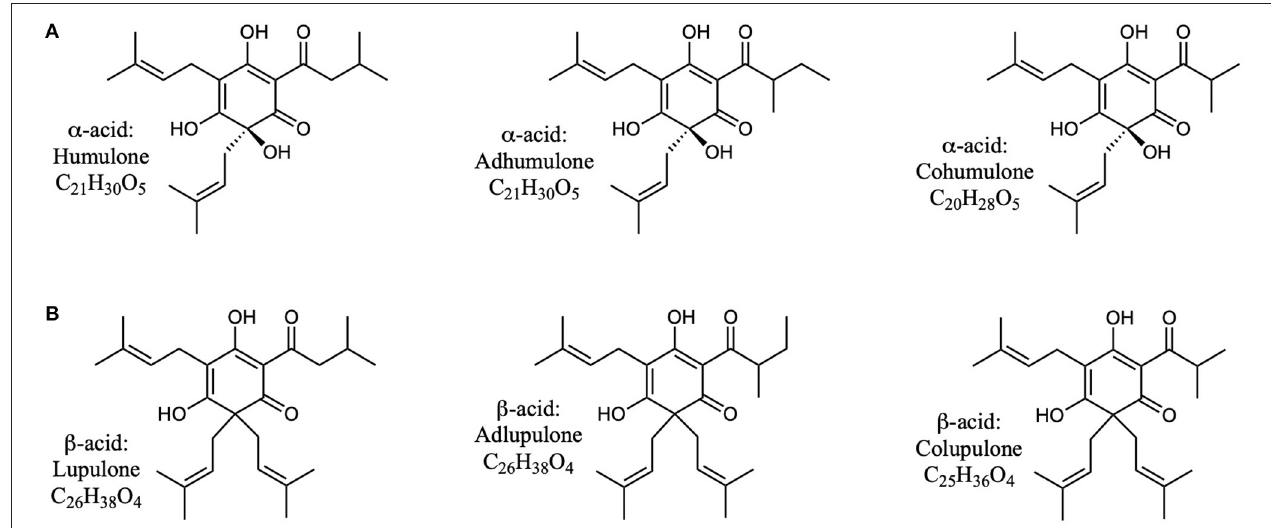
FIGURE 1 | Structures of α - and β -acids found in hops ( Humulus lupulus ). (A) The three common α -acids found in hops. (B) The three common β -acids found in